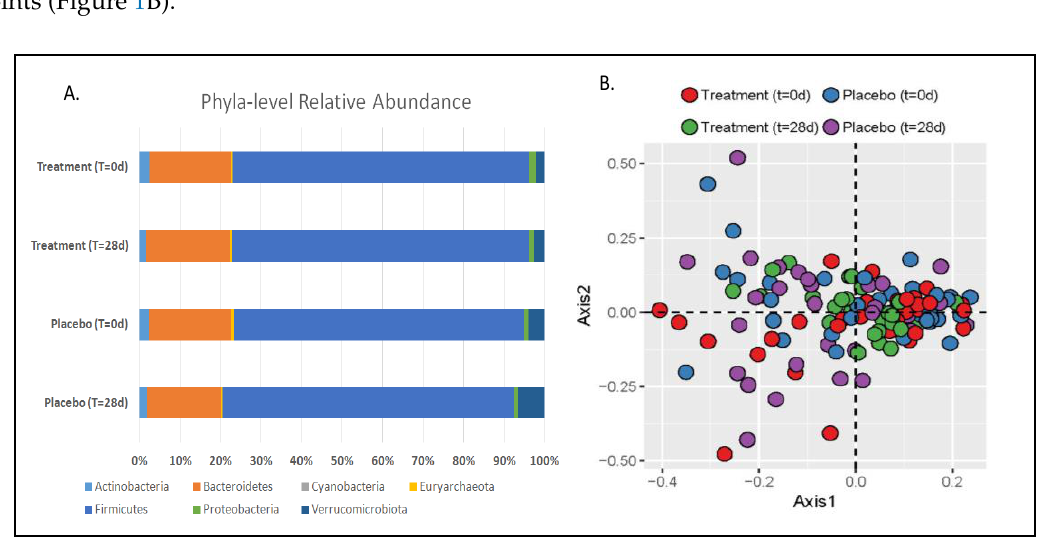
Figure 1. ( A ) Relative abundance of bacterial phyla detected in stool samples at baseline and after 28days for both phage (treatment) and placebo study periods. No significant differences were detected by analysis of covariance (ANCOVA) at p <0.05. ( B ) Principle coordinates analysis (PCoA) with nonmetric dimensional scaling of species-level Bray–Curtis distances. Stress = 0.191; perMANOVA (1000 permutations) Pr (> F ) = 0.996.